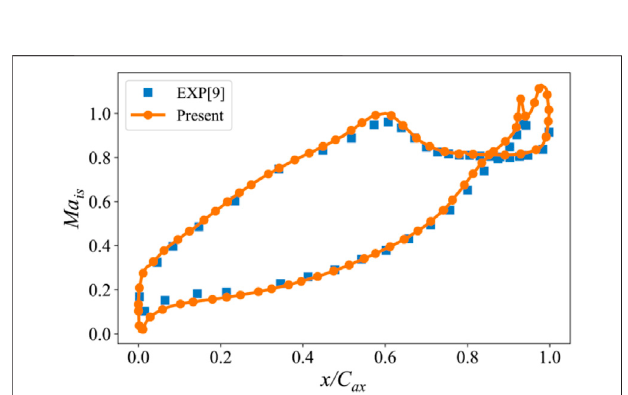
FIGURE 3 | The computational domain.